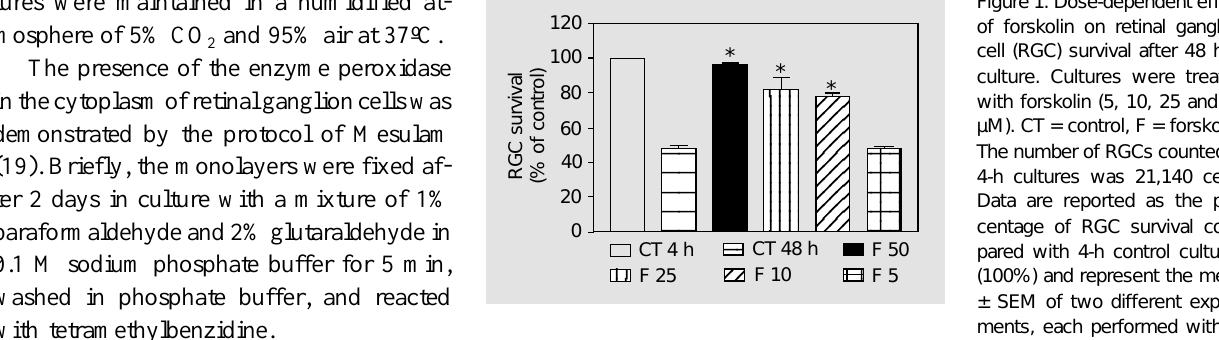
We used two different plating densities (130 cells/ mm 2 and 65 cells/mm 2 ). Forskolin enhanced the survival of retinal ganglion cells (RGCs) at both densities studied. The number of RGCs counted in 4-h cultures was 25,160 cells (130 cells/mm 2 ) and 12,670 cells (65 cells/mm 2 ). Data are reported as the percentage of RGC survival compared with 4-h control cultures (100%) and represent the mean ± SEM of three different experiments, each performed with at least three different Petri dishes (N = 3-4). *P<0.001 compared to the 48-h control (Newman-Keuls